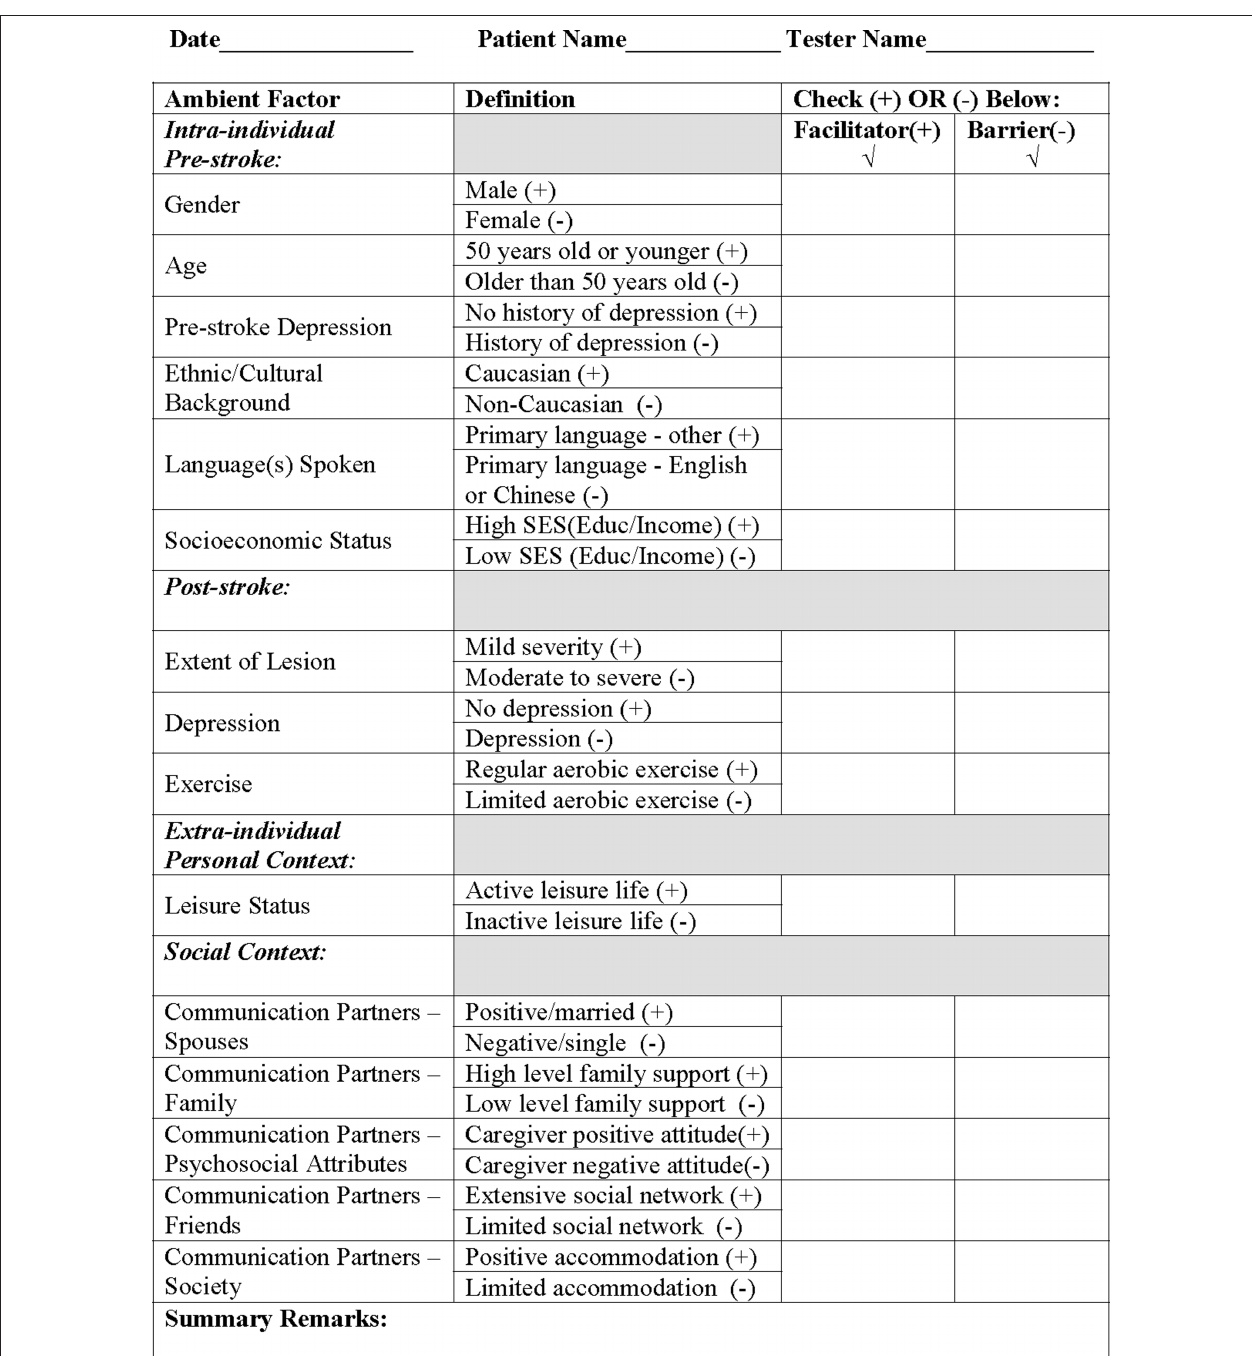
Figure 2 | Ambient influences on outcome Checklist (AoC) McClung, gonzalez rothi, and Nadeau (2010). This Checklist has been developed as a guiding tool only. No attempt has been made to test its validity or reliability.